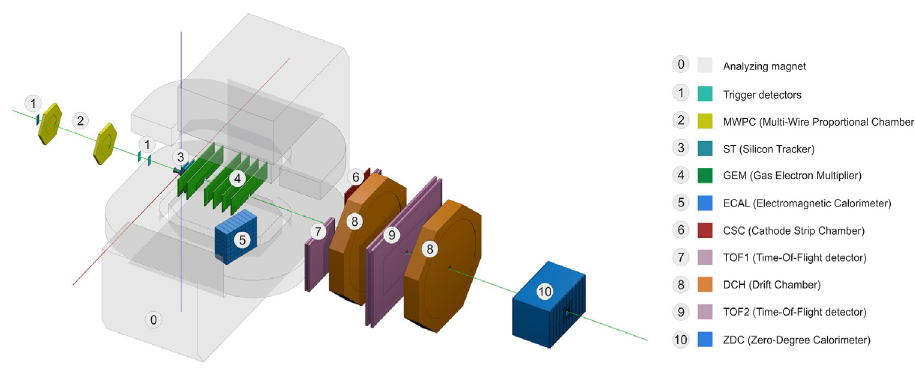
Fig. 1. Schematic view of BM@N in the last run (March-April,